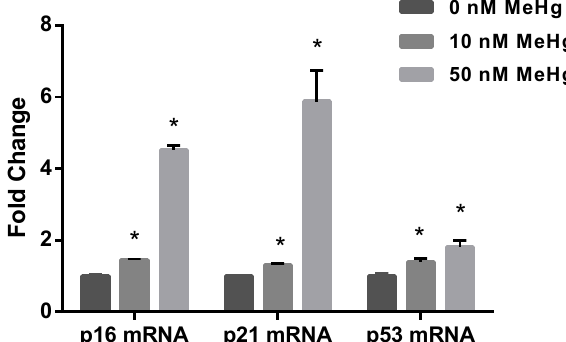
Figure 2. Effect of MeHg on cell cycle regulatory genes in ihNPCs. Quantitative real time polymerase chain reaction (qPCR) analysis of p16, p21 and p53 mRNA expression levels performed on RNA extracted from ihNPCs treated with 0 nM, 10 nM and 50 nM MeHg, respectively. β -Actin was used for normalization. Fold change RNA was normalized over 0 nM MeHg. Results are expressed as mean ± SEM ( n = 3). * p < 0.05 when compared with the corresponding control group (0 nM MeHg).